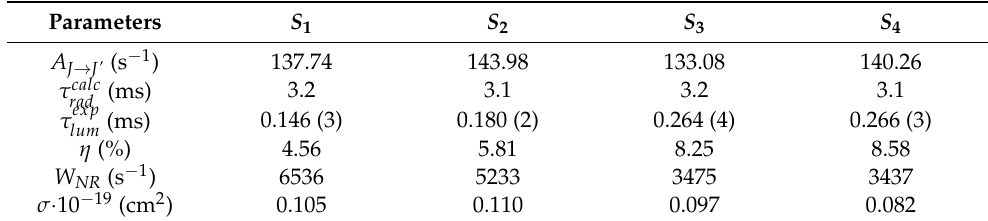
Table 5. Radiative decay rates ( A J → J’ ), radiative decay time τ calc intrinsic quantum yield ( η ), non-radiative multiphonon decay rates ( W NR ) of the 4 I 13/2 multiplet, and the values of emission cross section ( σ ) of the 4 I 13/2 → 4 I 15/2 electron transition in Er 3+ -doped YAG (YSAG) ceramics at 300